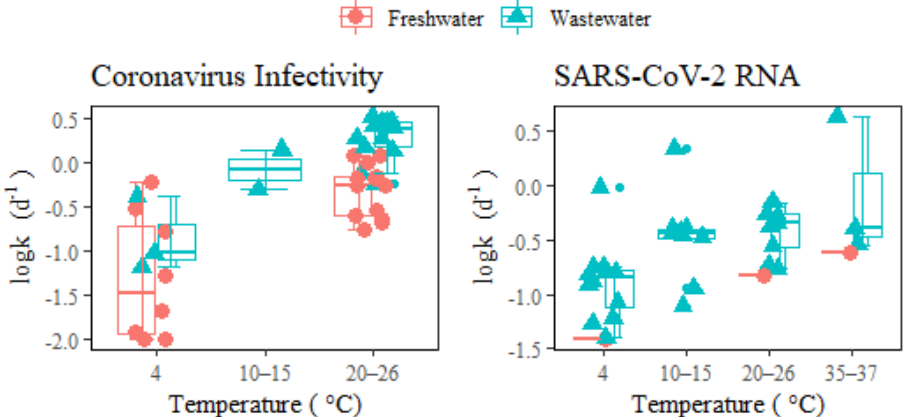
Figure 1. Decay of coronavirus infectivity and SARS-CoV-2 RNA in freshwater and wastewater under different temperatures. The middle lines inside the box represent median k values. The top and bottom borders of the box represent the 75%ile and 25%ile of k values, respectively. The top and bottom whiskers represent the upper and lower limit of k values in the groups. In addition, the smaller dots represent the outliers.